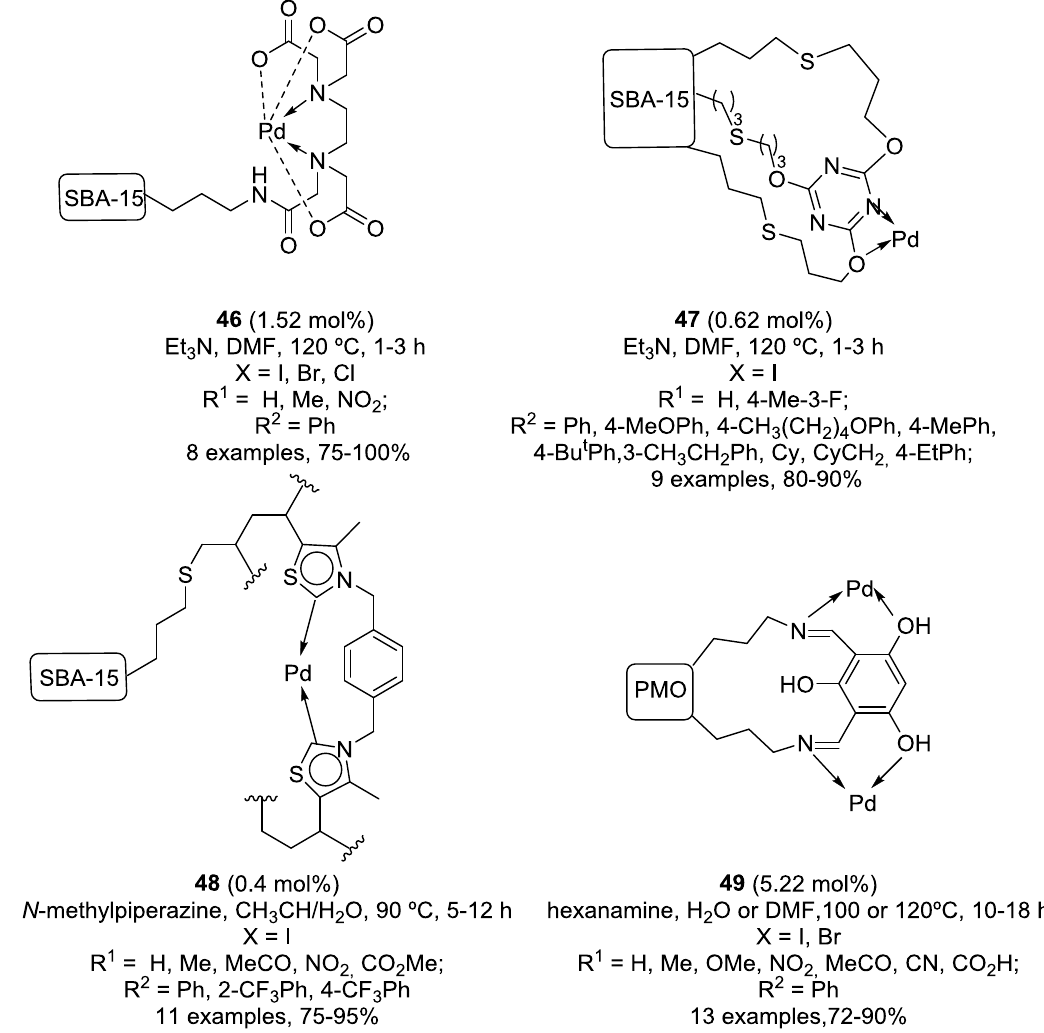
Figure 16. Mesoporous silica-supported catalysts used for the Sonogashira reaction. Conditions, substrate scope and yield range (Scheme 2).